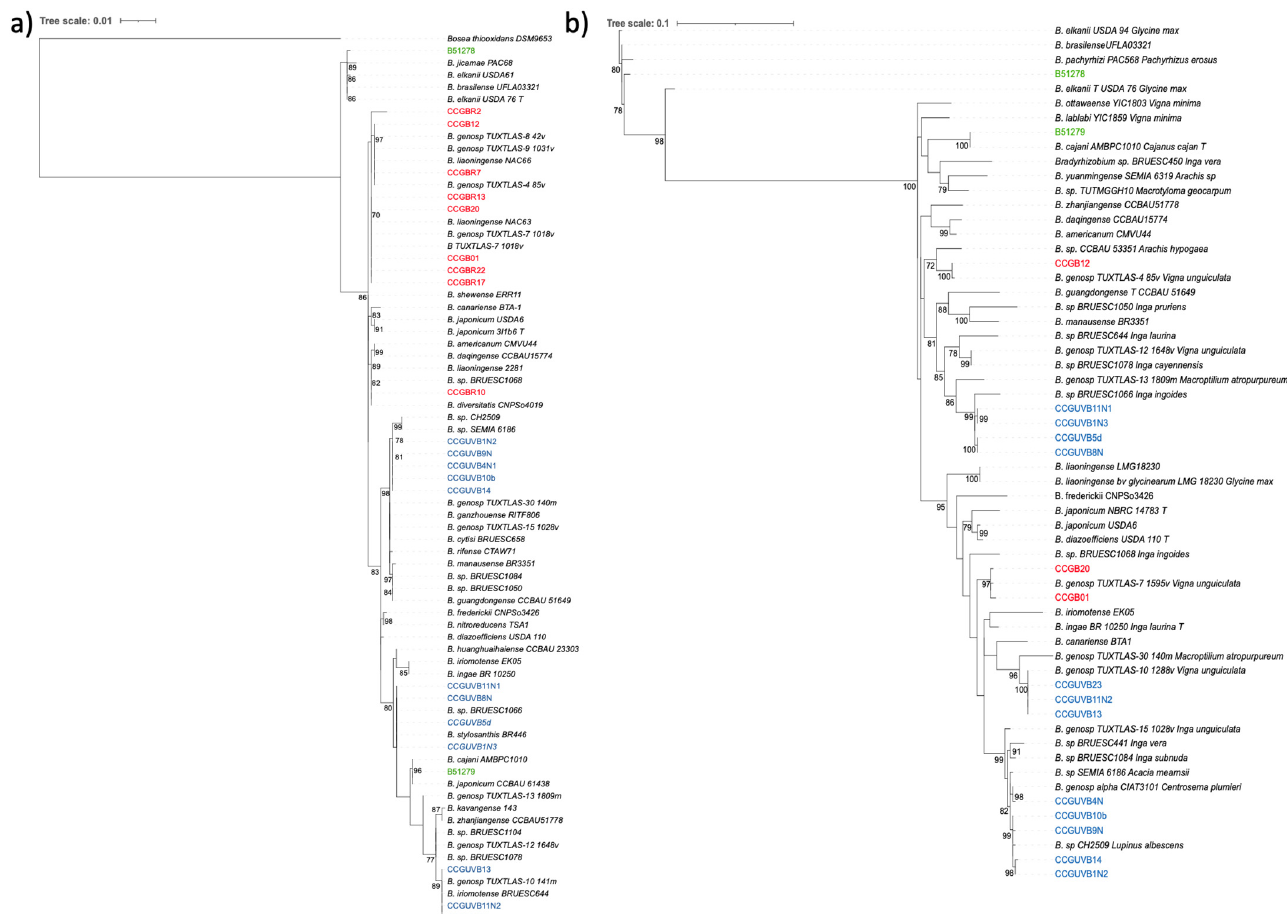
Figure 2. Maximum-likelihood phylogenetic trees based on ( a ) 16S rRNA and ( b ) glnII gene sequences showing relationships between Lysiloma sp., L. divaricatum , Inga vera isolates and other strains from genus Bradyrhizobium . Alignment lengths: 1196 bp 16S rRNA; 523 bp glnII . Substitution model: GTR+I+G for both phylogenies. Bootstrap values lower than 70% are not shown. Blue for I. vera isolates, red for Lysiloma sp. isolates, green for L. divaricatum isolates. Bosea thiooxidans DSM9653(T) was used as an external group on 16S rRNA phylogeny. T, type strain.